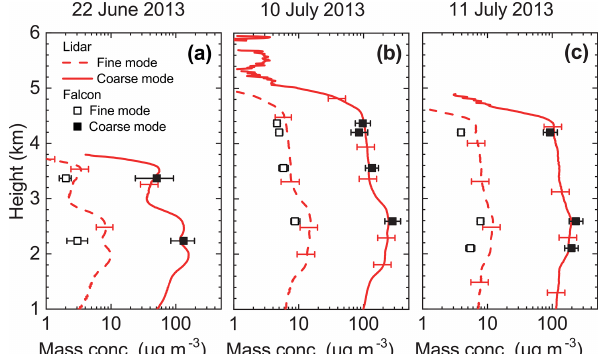
Figure 5. Mass concentration of fine-mode ( r < 500nm; dashed line) and coarse-mode ( r > 500nm; solid line) dust derived from airborne in situ measurements (black squares) and lidar observa- tions (red profiles) for the three SALTRACE-1 days. The error bars of the in situ measurements indicate the 16th and 84th